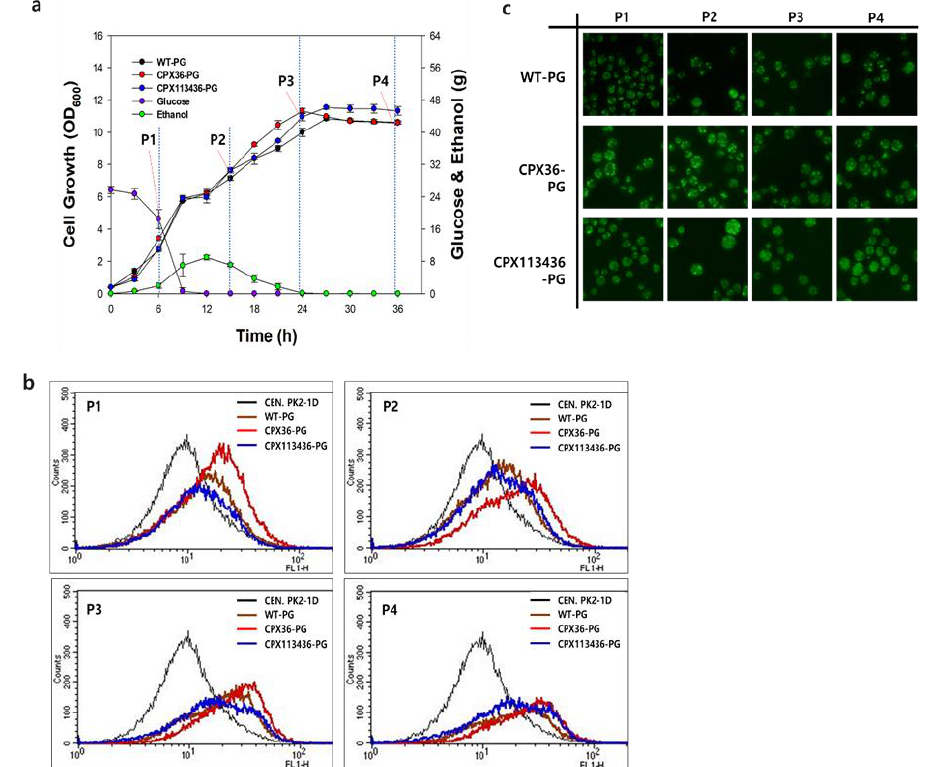
Figure 3. Peroxisome stability in peroxisome-engineered CPX36-PG and CPX113436-PG strains in a bioreactor. ( a ) Cell growth of WT-PG (low copy number: ca. 3.5 ± 1.4 copies per cell ( n = 6)), CPX36-